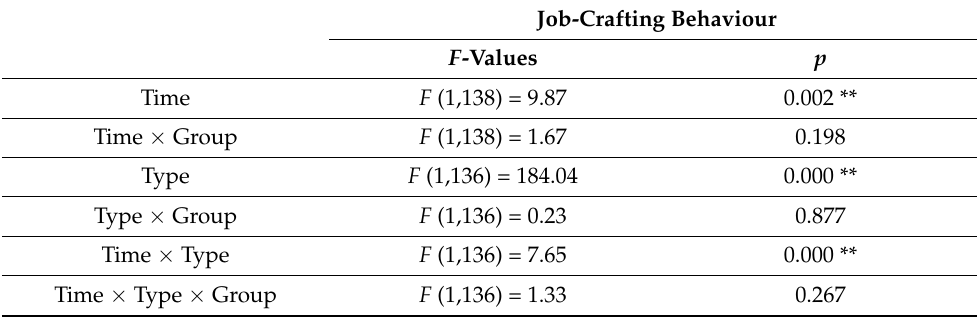
Table 3. Results of RM MANOVAs for Time × Group × Type of job-crafting behaviour. Job-Crafting Behaviour F -Values p Time F (1,138) = 9.87 0.002